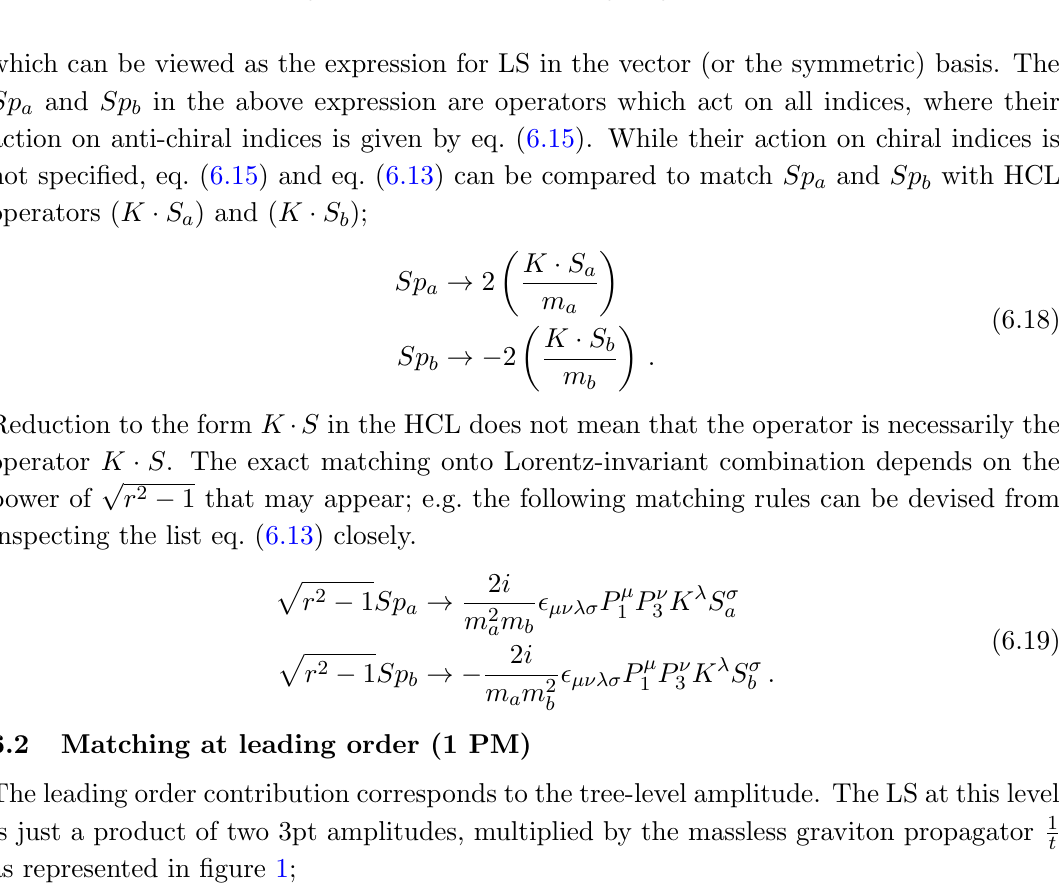
Figure 1 . A graphical representation of gluing two 3pt